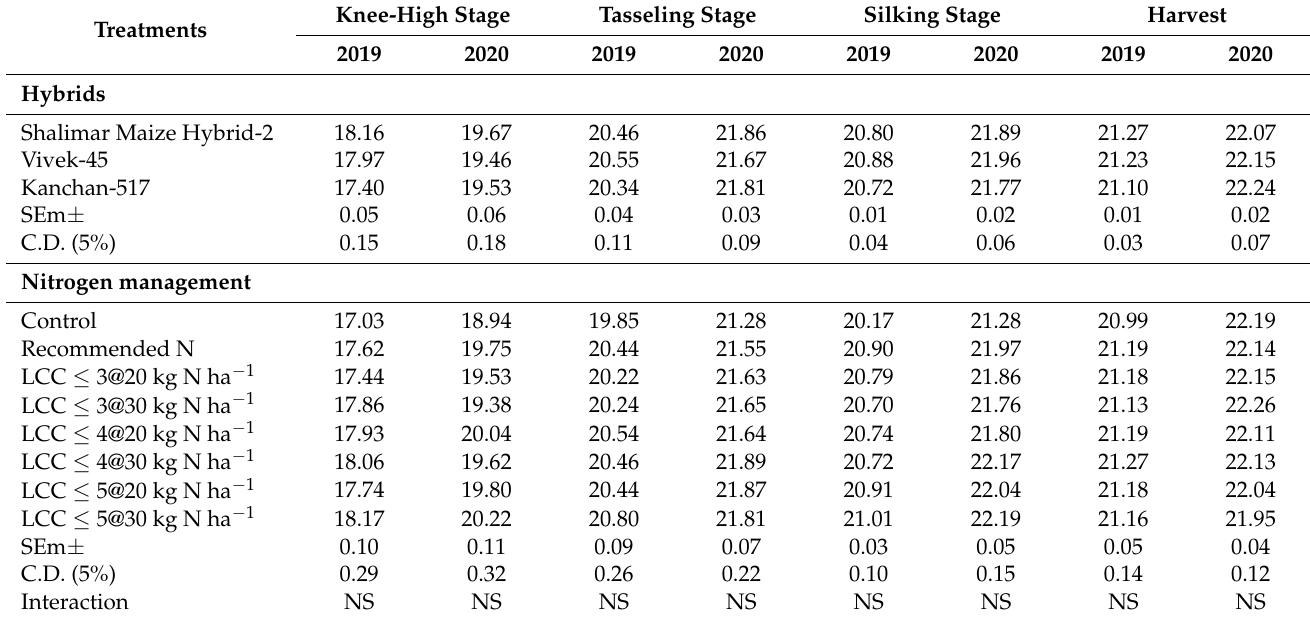
Table 7. Effect of precision nitrogen management through LCC on Phenothermal index ( ◦ C day day − 1 ) of different hybrid maize